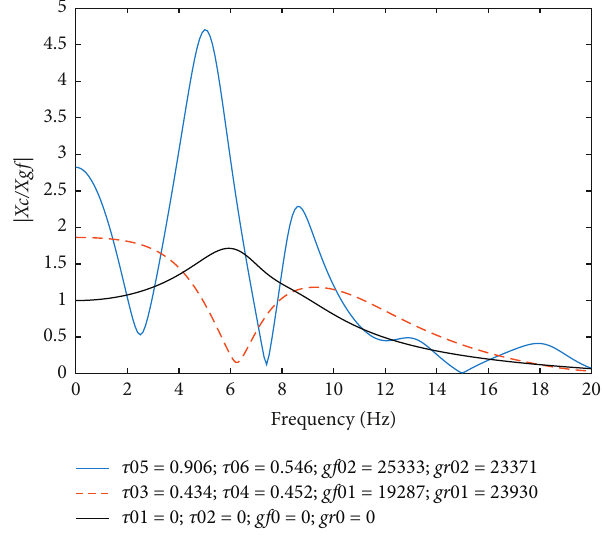
Figure 2: Amplitude-frequency response